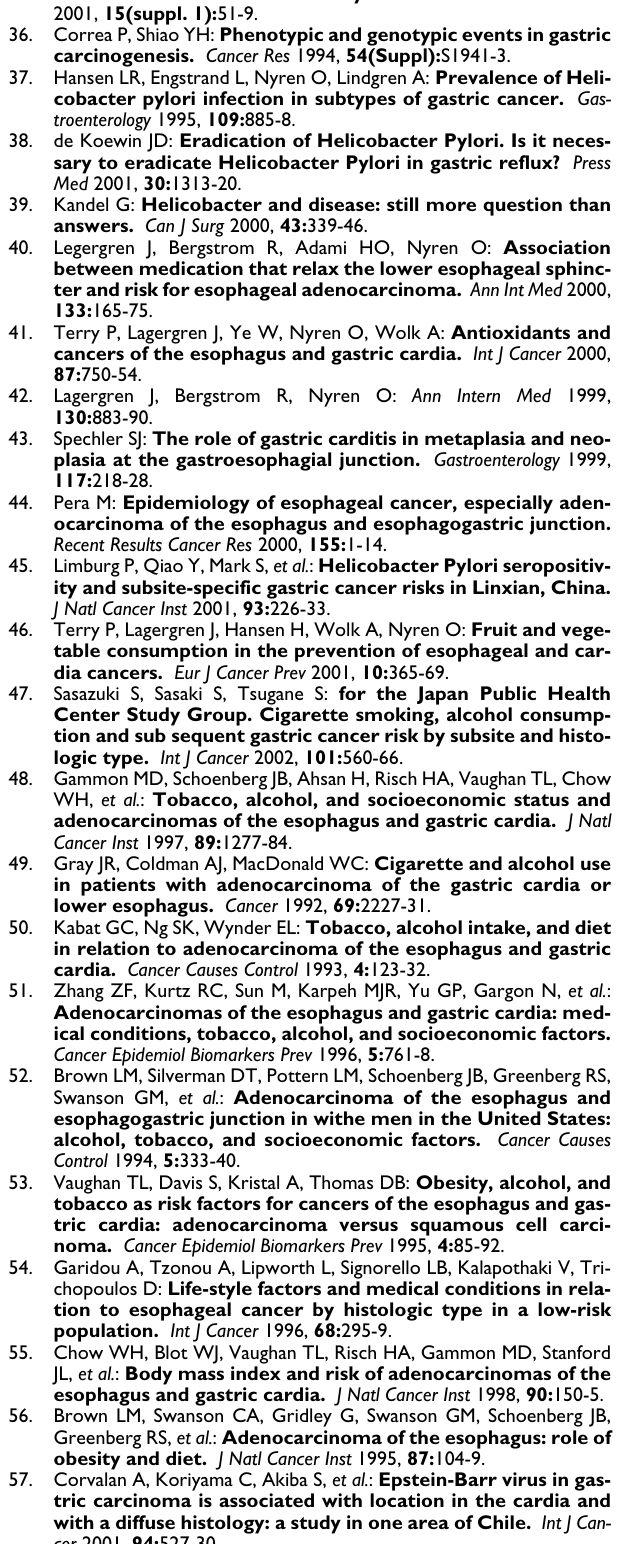
table consumption in the prevention of esophageal and car- dia cancers. Eur J Cancer Prev 2001, 10: